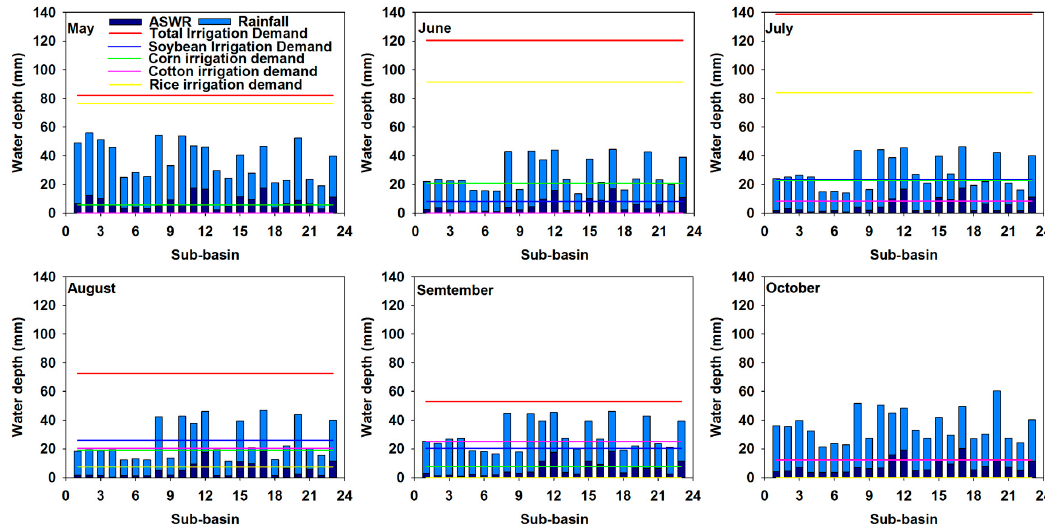
Figure 5. Comparisons between averaged weekly available surface water potential (ASWR) and weekly irrigation demands for soybean, corn, cotton, and rice in each subbasin from May to October in Big Sunflower River Watershed. * ASWR is defined as: ASWR = 80% SWRP + PWRP; SWRP is defined as: SWRP = SWR − (SE + ST); SWR is stream water resources, SE is stream water evaporation, ST is stream transmission; PWRP is defined as: PWRP = PWR − PE; PWR is pond water resources, PE is pond water